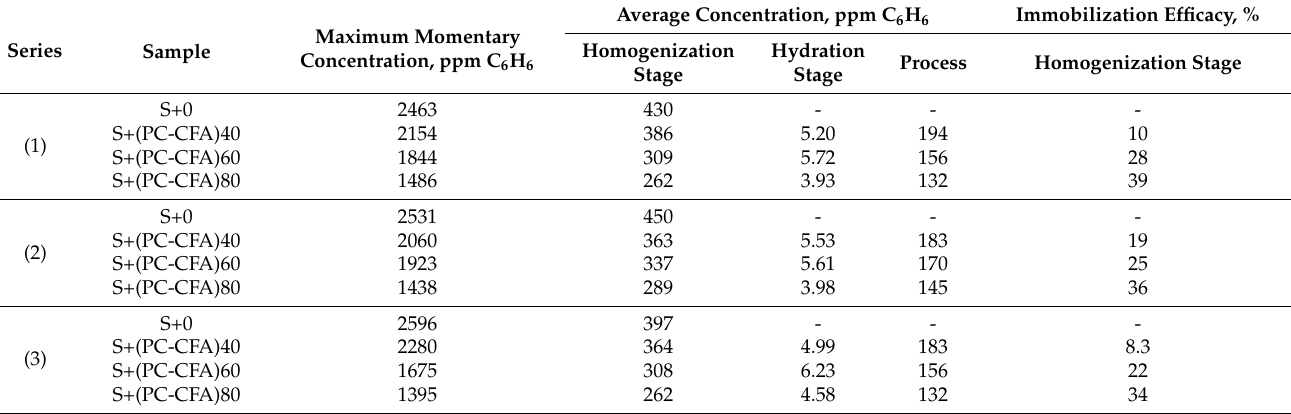
Table 2. PC-CFA mixture